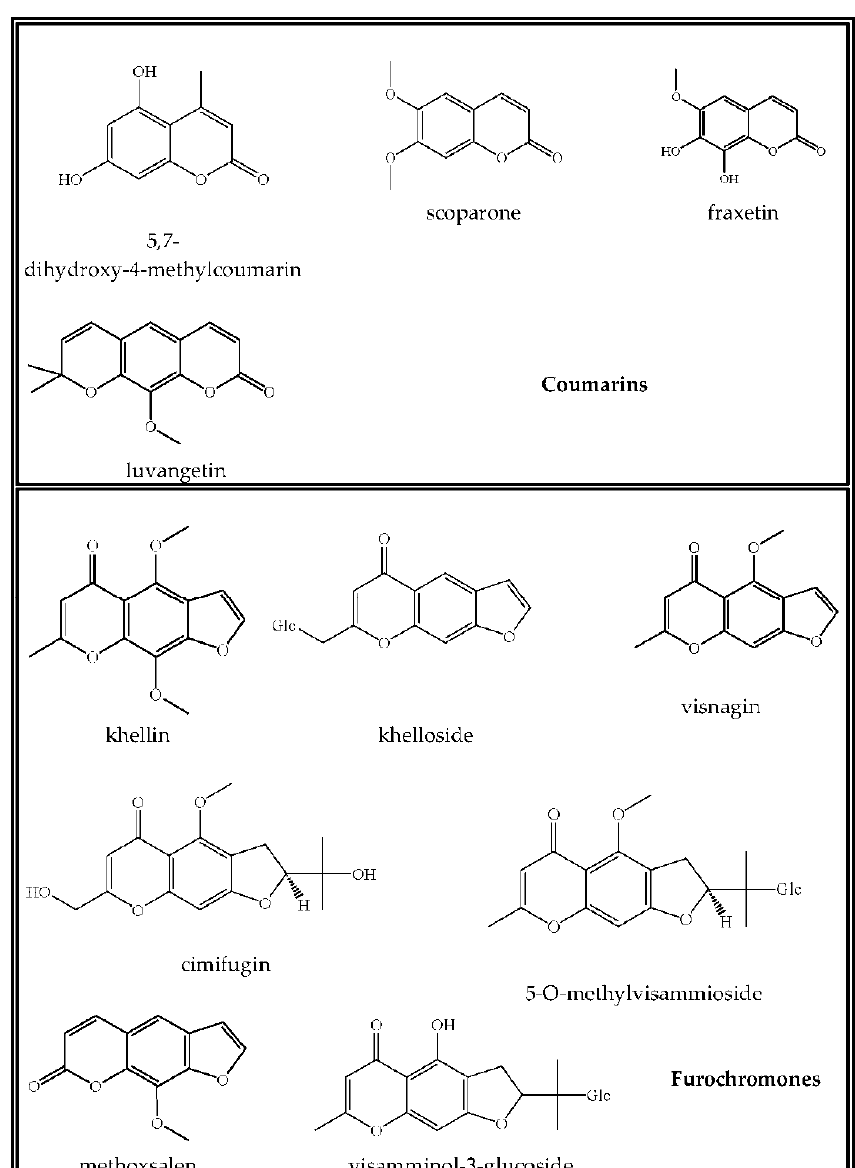
Figure 2. Structures of coumarins and furochromones from E. longistipitata .